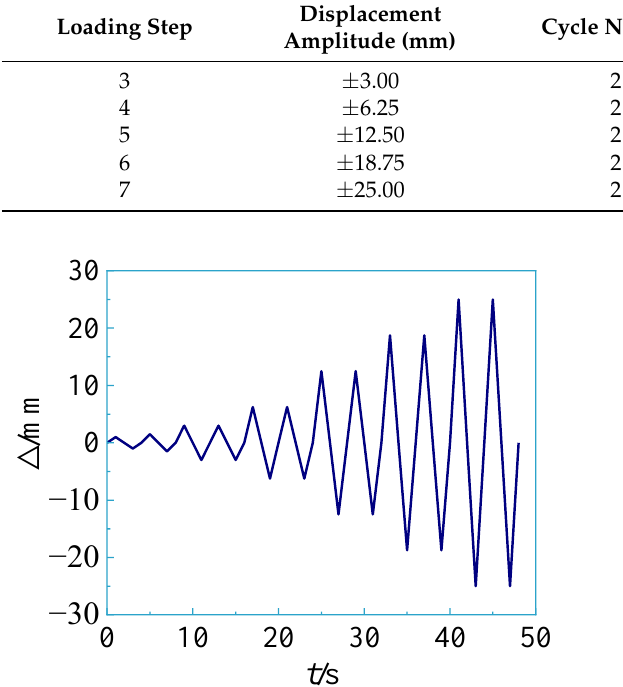
Figure 5. Test loading protocol diagram. Table 5. lateral cyclic loading protocol.